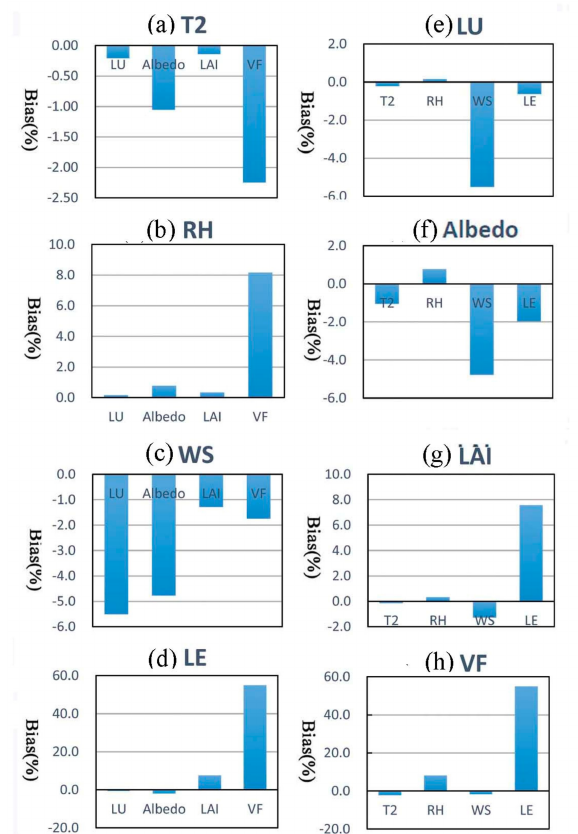
Figure 12. Average bias percentages of simulated meteorological variables at six stations due to using each actual terrestrial dataset: ( a ) T2, ( b ) RH, ( c ) WS, ( d ) LE, ( e ) biases due to using actual LU data, ( f ) biases due to using actual albedo data, ( g ) biases using actual LAI data, and ( h ) biases due to using actual VF